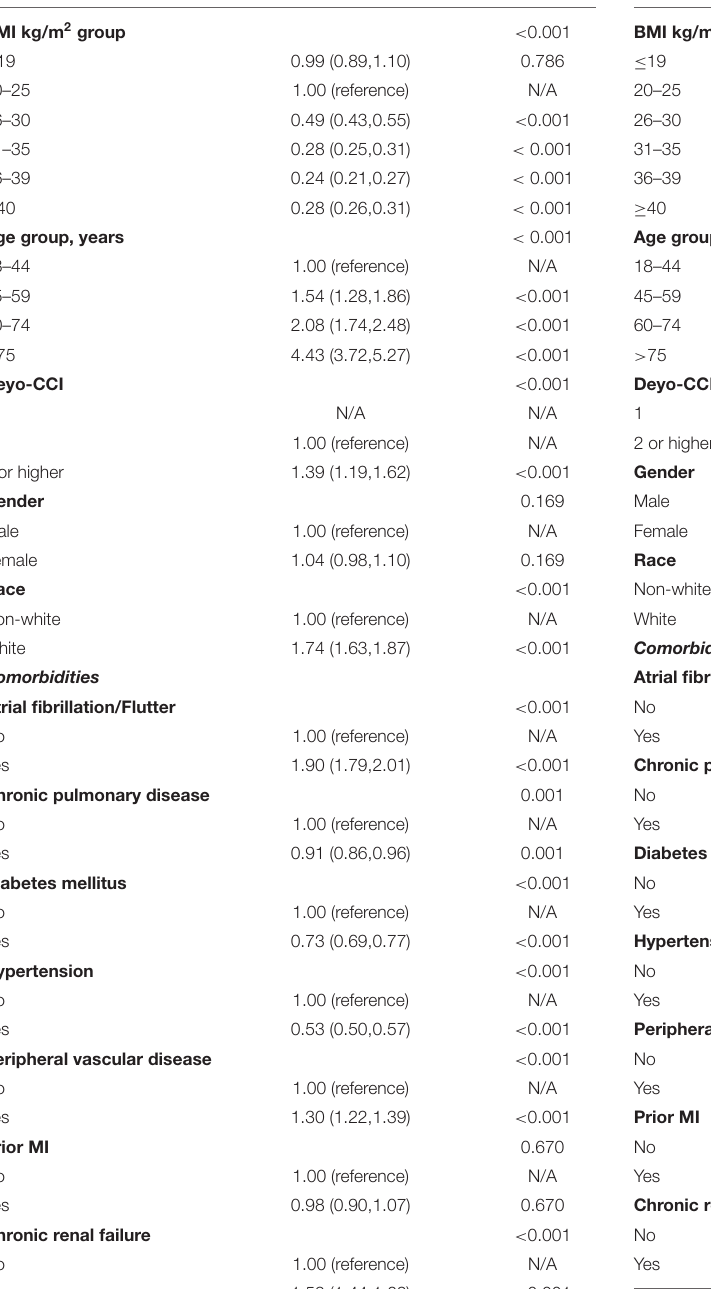
TABLE 2 | Univariate analysis for predictors of in-hospital mortality, 2015–2016. Predictor